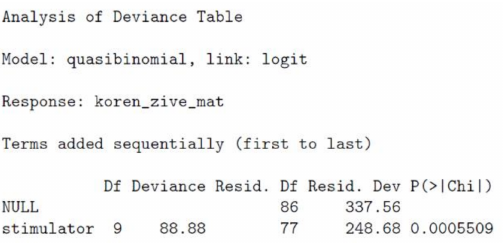
Figure A8. LR-test of the significance of Stimulator as the only factor for the proportion of rooted cuttings from the number of survived